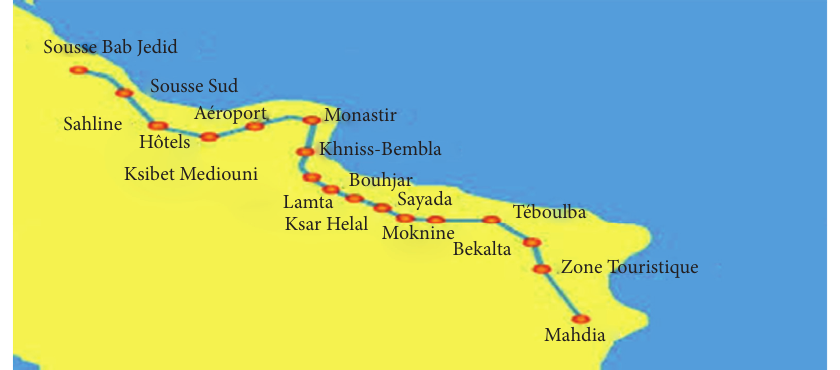
Figure 1: Sahel railway network.